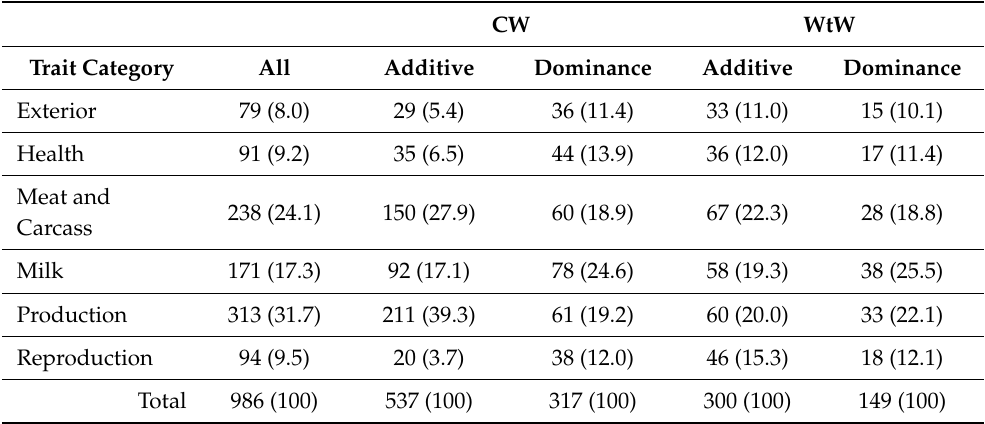
Table 6. Number (%) of QTL containing variants associated 1 with additive and dominance effects on 8-year-old cow weight (CW) and cumulative weight weaned (WtW). CW WtW Trait